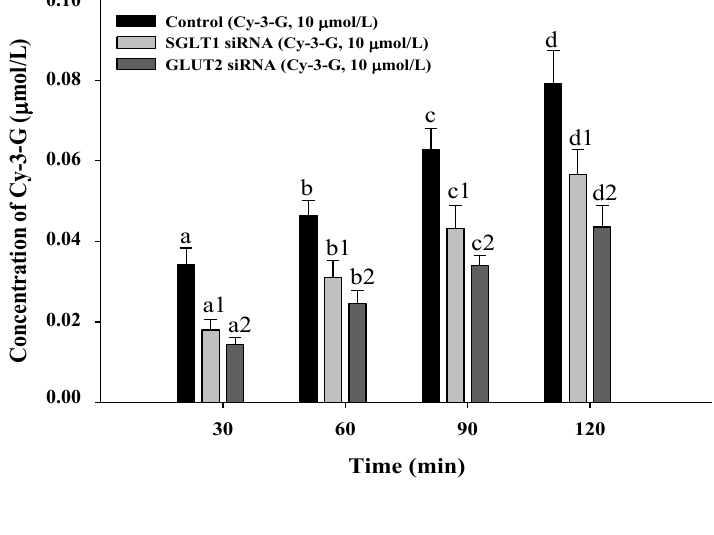
Figure 5. Absorption of Cy-3-G in Caco-2 cells after siRNA transfection. After transfection for 48 h, Cy-3-G absorption was measured. Values without a common letter differ, p <